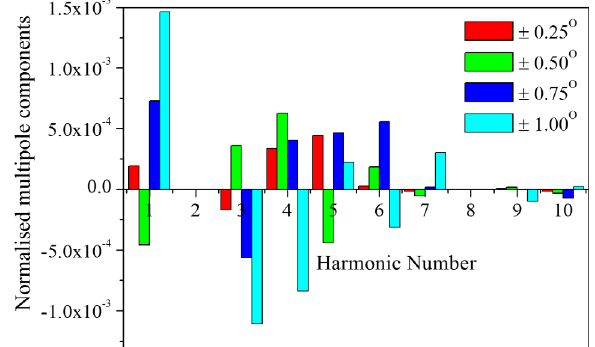
FIG. 5. Values of normalized multipole components for the model having 12 PMs each having a 6 mm radius for the cases where the direction of magnetization of each magnet randomly varies by (cid:3) 0 . 25 °, (cid:3) 0 . 50 °, (cid:3) 0 . 75 °, and (cid:3) 1 . 0 °, respectively, from its ideal orientation.